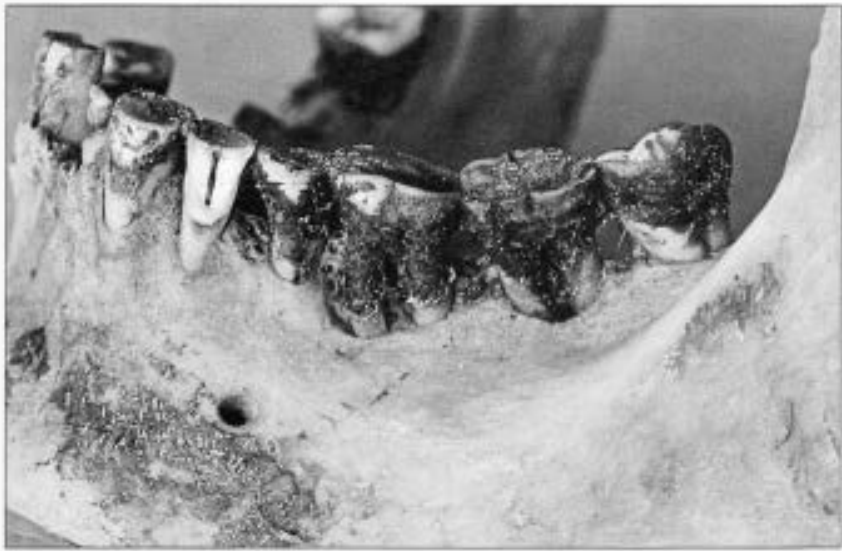
A Chiribaya lower jaw from Chiribaya Baja in the Ilo valley. The rest of the skeleton shows this to be a middle-age man, but the teeth are already substantially worn. The black, stained deposits of calculus on the molars and premolars also suggest the periodontal inflammation possibly associated with coca